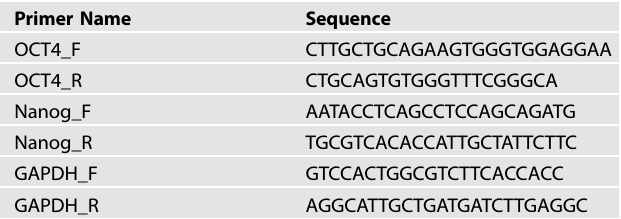
Table 1. The primer sequences used in RT-qPCR